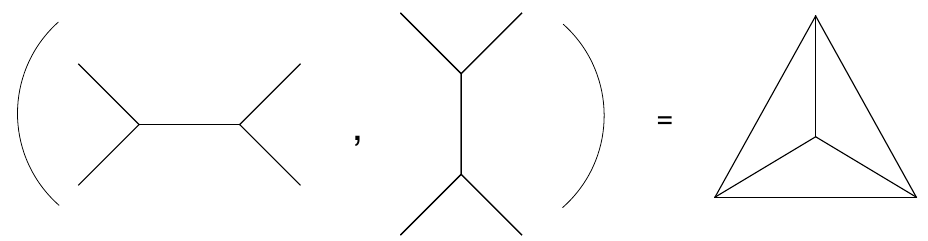
Figure 1. The inner product of an s -channel conformal partial wave and a t -channel conformal partial wave is a 6 j symbol, represented by a tetrahedron. Each line represents a coordinate, and each vertex is a conformal three-point